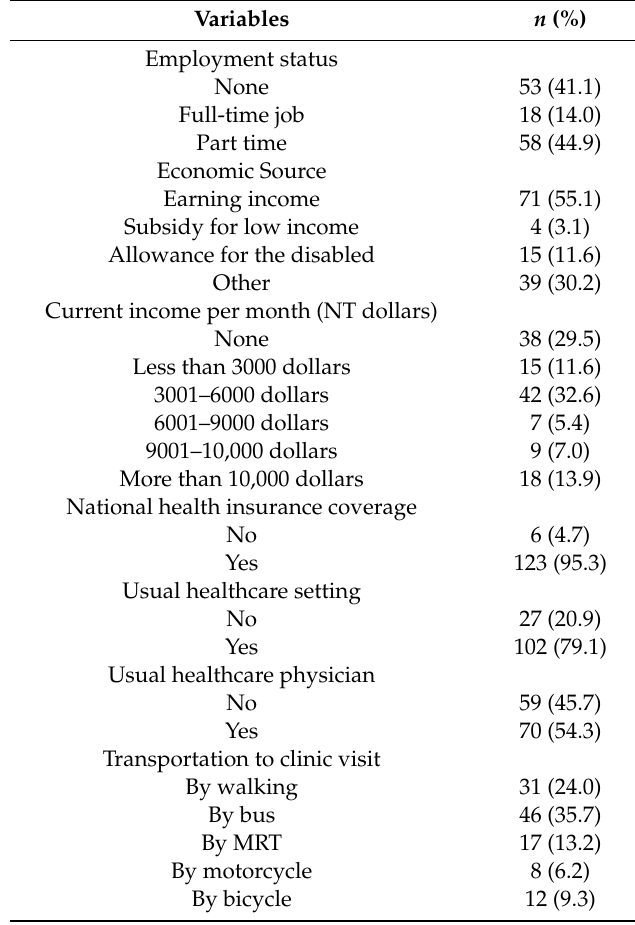
Table 2. The distribution of enabling and need conditions in middle- and old-aged homeless people ( n =